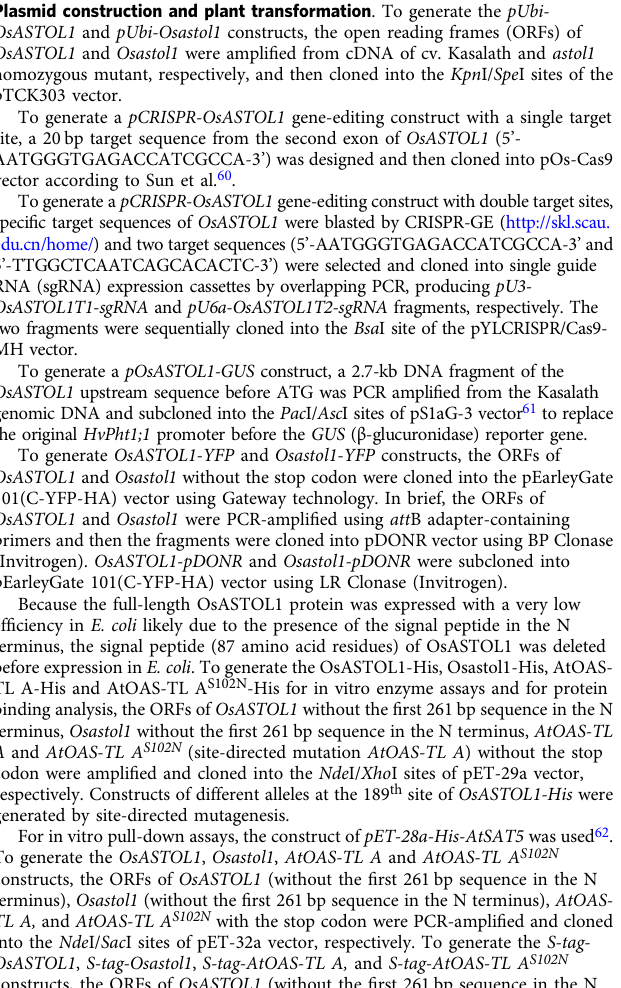
Supplementary Table 1. To evaluate the effects of OsASTOL1 overexpression or knockout, 5-week-old rice seedlings of wild-type Kasalath, astol1 heterozygous mutant, knockout lines, overexpression lines, and null lines in different background genotypes were exposed to half strength Kimura B nutrient solution containing 5µM As(III) for 3 days. The background of transgenic plants was genotyped by a derived cleaved ampli fi ed polymorphic sequence (dCAPS) marker ( Dde I) targeting the mutated site of Osastol1 in astol1 . The primers used are listed in